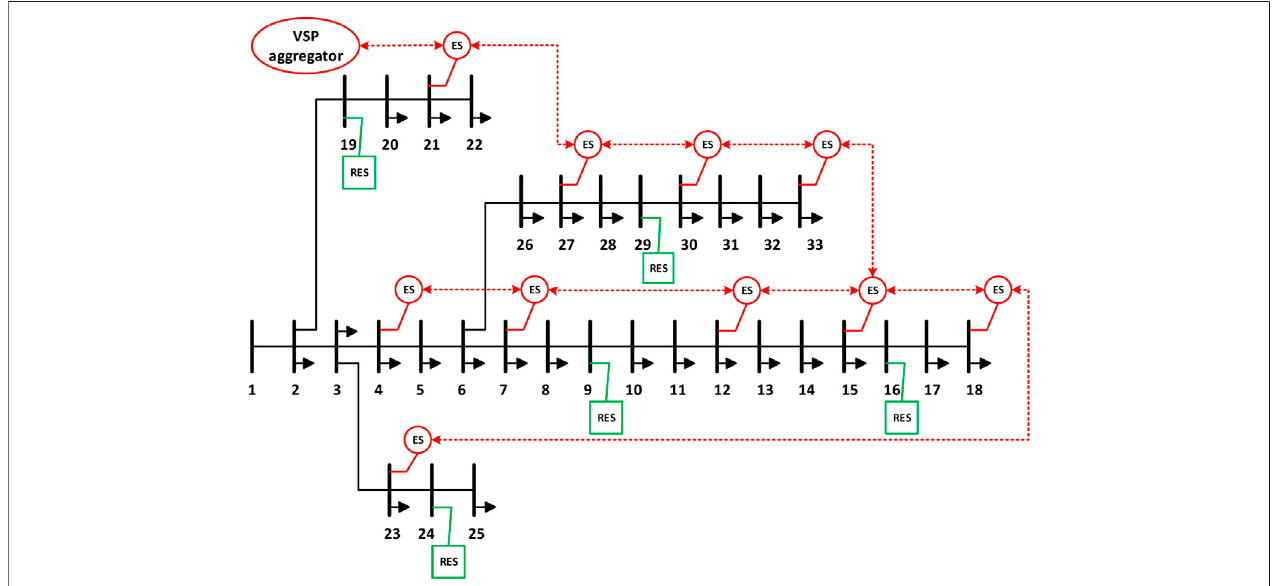
FIGURE 1 | Diagram of the IEEE 33-bus system with distributed energy storage systems aggregated as a VSP (black solid line: distribution lines; red dashed line: communication lines).